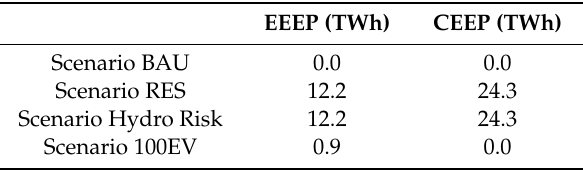
Figure 4. Power output on a spring week for scenario RES—Daily charging strategy. Table 1. Exported Excess Electricity Production (EEEP) and Critical Excess Electricity Production (CEEP) for all scenarios (TWh).